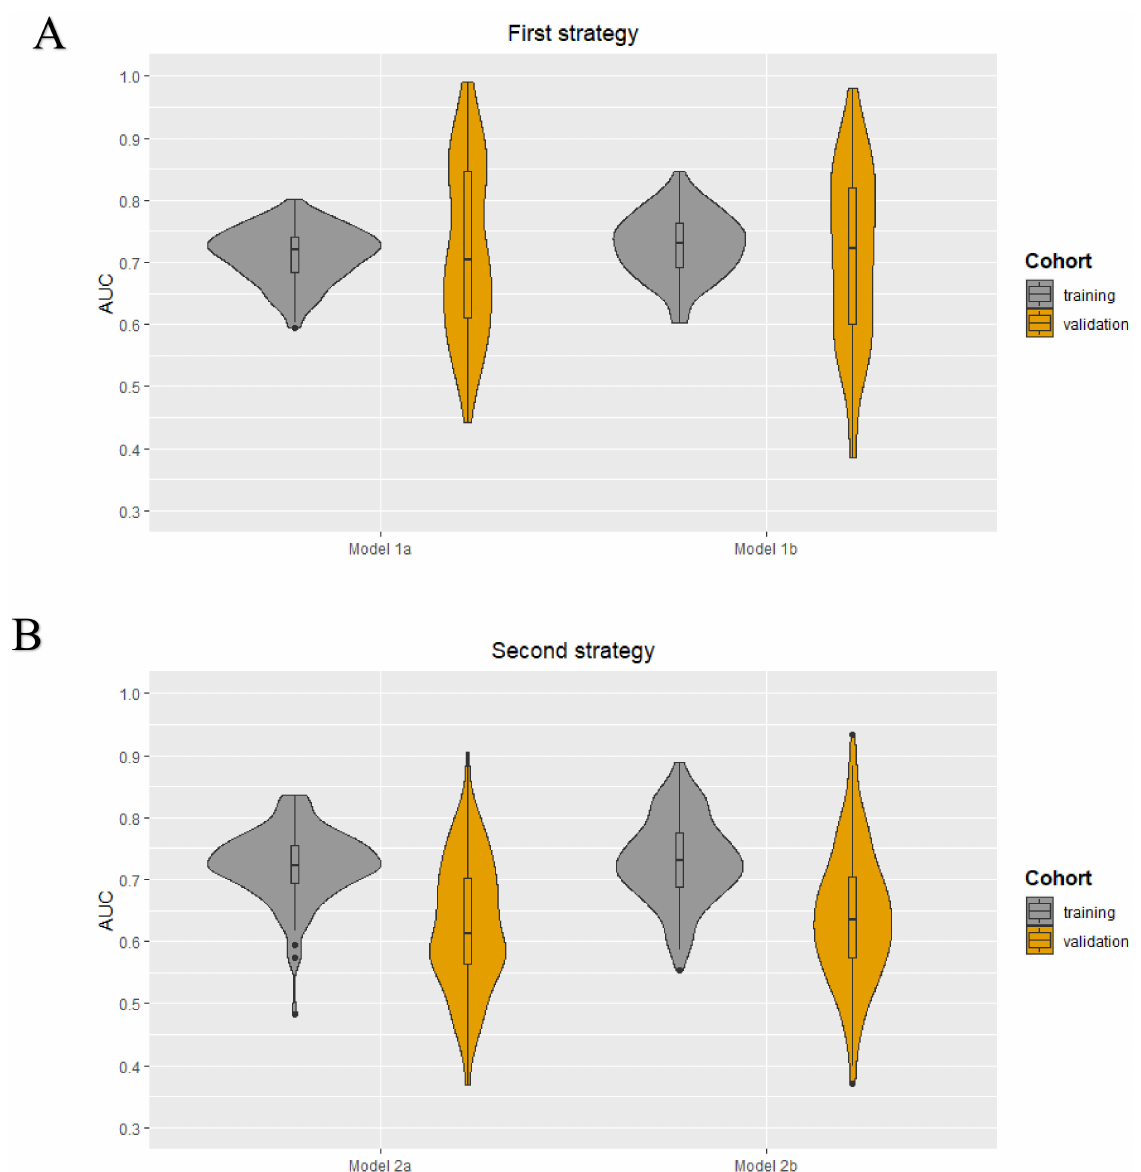
Figure 2. Violin plots for the radiomics models developed using the first ( A ) and second ( B ) strategy: AUC value distribuTable 100. iterations) for the four models (1a, 1b, 2a, and 2b) in both the training and validation